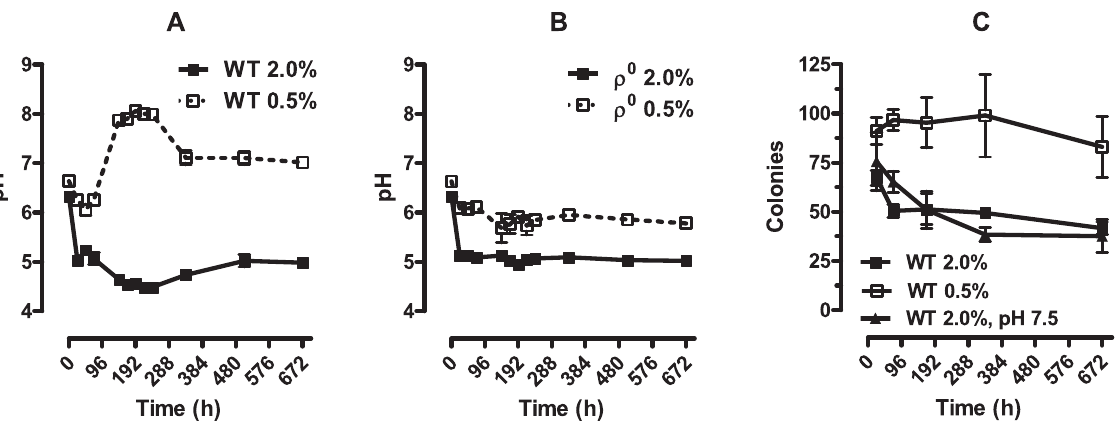
Figure 3. Extracellular pH changes during chronological lifespan. Extracellular pH (Panels A and B) was determined as described in Materials and Methods in the culture media of WT and r 0 (Panels A and B, respectively) S. cerevisiae over the course of chronological aging. In Panel C, the chronological lifespan of WT cells cultured under control and CR conditions was followed over time. Hepes (100 mM) was added to maintain the pH at 7.5 where indicated. Values are expressed (means 6 SEM) indicate the number of colonies formed from 100 cells plated onto solid YPD media.